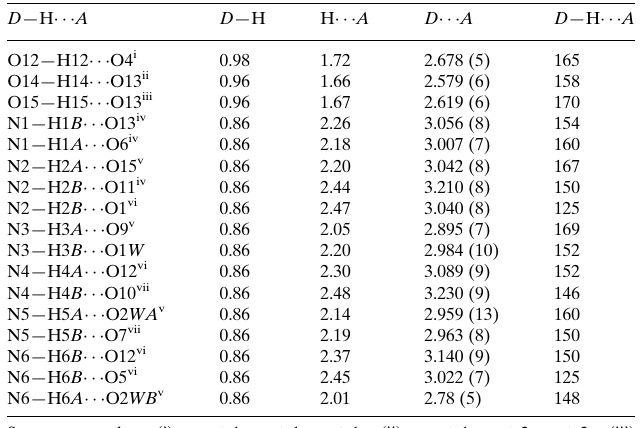
Hydrogen-bond geometry (A˚ , (cid:3)